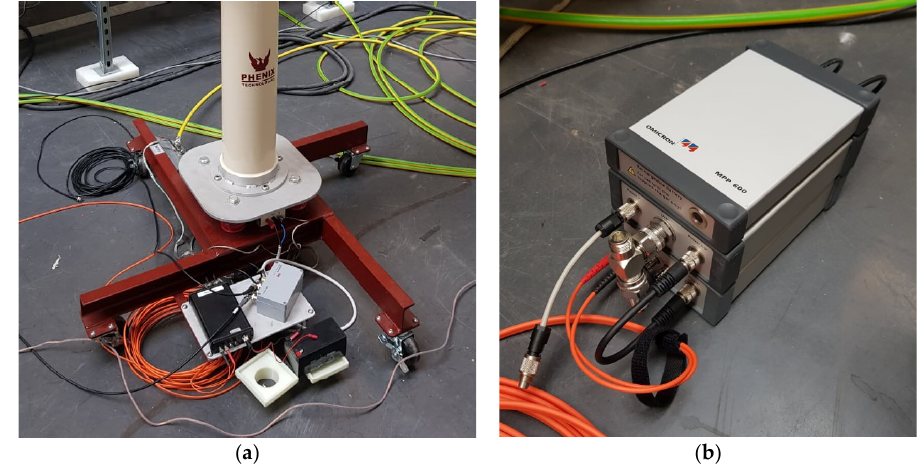
Figure 4. ( a ) Optically isolated partial discharge (PD) equipment coupled to a coupling capacitor of 1 nF or power seperation filter; ( b ) ultra high frequency (UHF) capacitive sensor coupled with optically isolated PD measurement equipment.